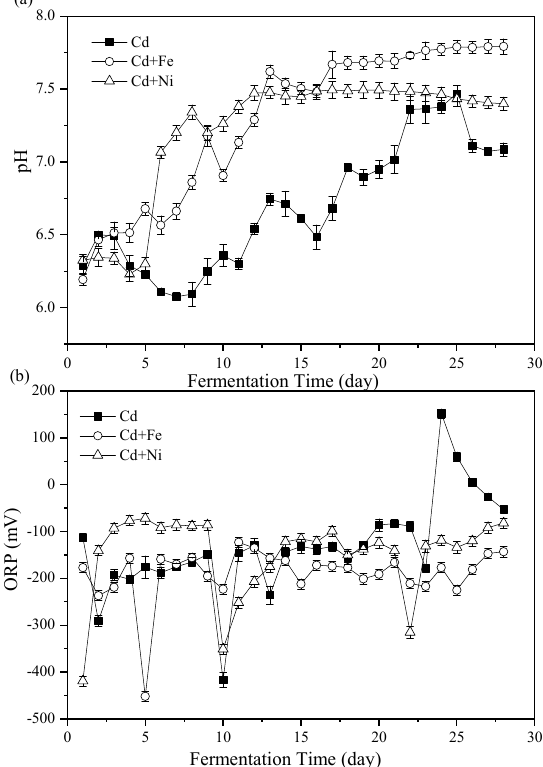
Figure 2. Impact of Cd, Cd + Fe, and Cd + Ni addition on pH values ( a ) and oxidation reduction potential (ORP) ( b ) during the fermentation.